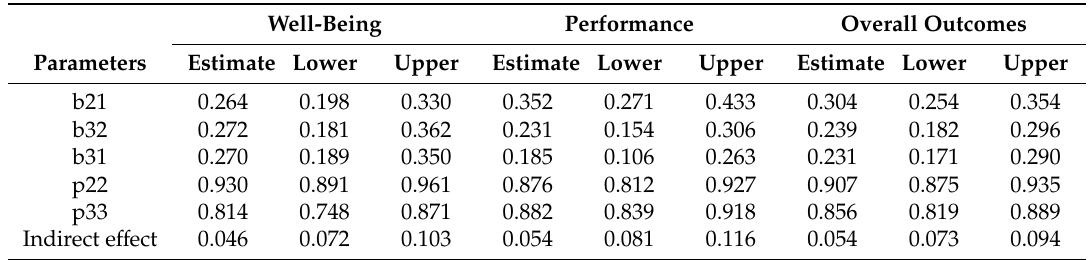
Table 5. Parameter estimates and 95% confidence intervals for studies with di ff erent mediators (H2). Well-Being Performance Overall